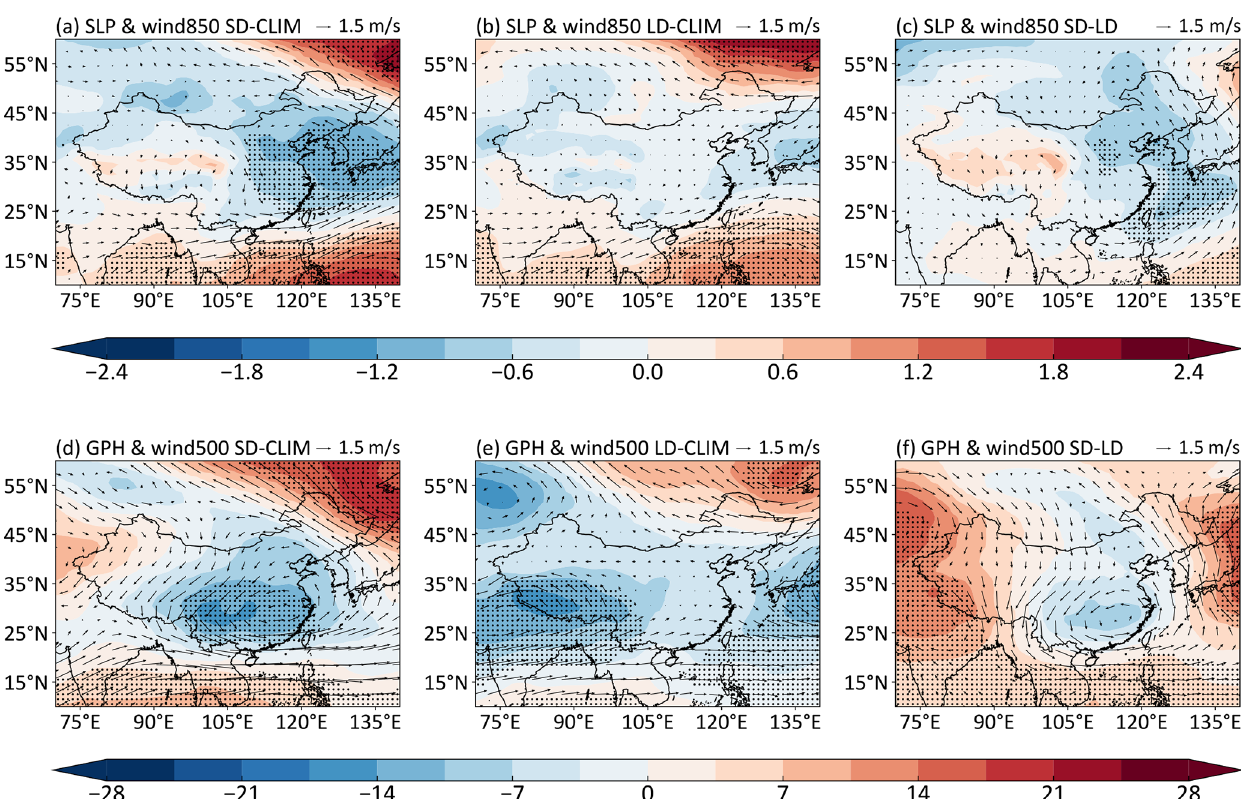
Figure 6. Composite differences in DJF mean sea level pressure (SLP, shaded; unit: hPa) and wind at 850hPa (WIND850, vector; unit: ms − 1 ) (a) – (c) and geopotential height at 500hPa (GPH500, shaded; unit: m) and wind at 500hPa (WIND500, vector; unit: ms − 1 ) (d) – (f) between SD and CLIM (a, d) , LD and CLIM (b, e) , and SD and LD (c, f) . The stippled areas indicate statistical significance with 90% confidence from a two-tailed t